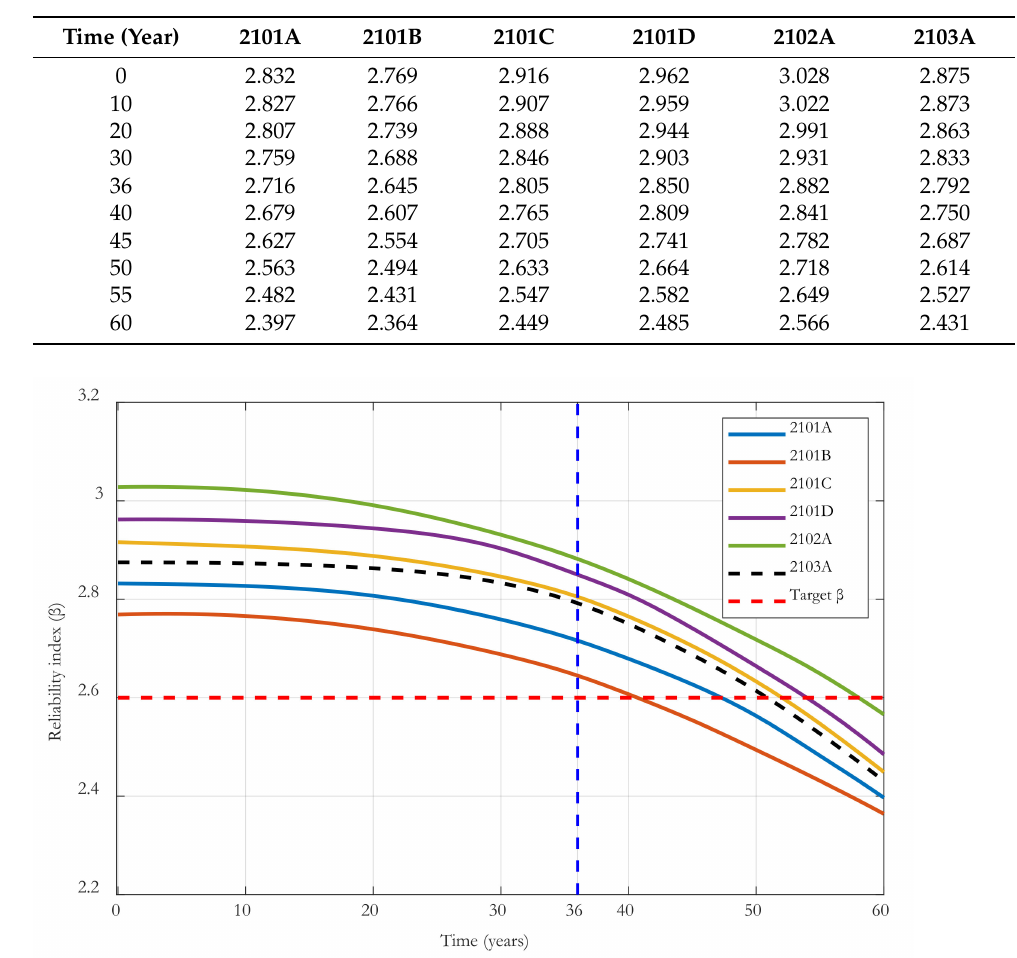
Table 14. Reliability analysis results.